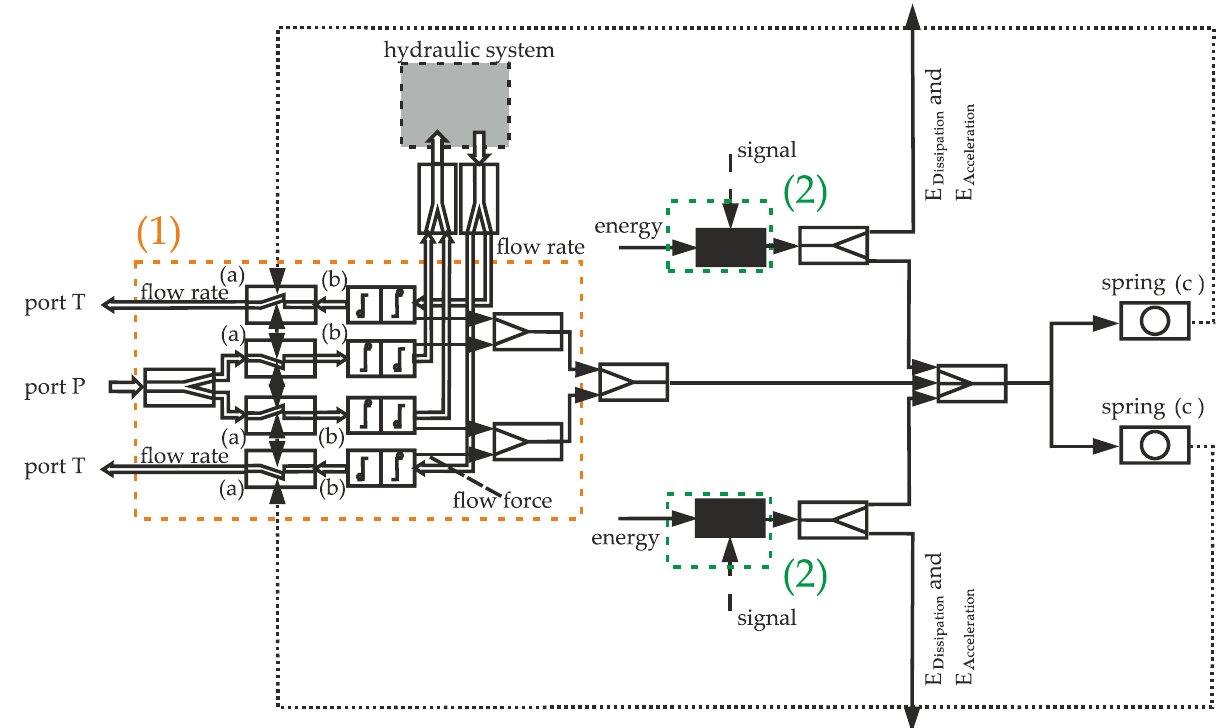
Figure 3. The function structure of a valve and its actuation system.